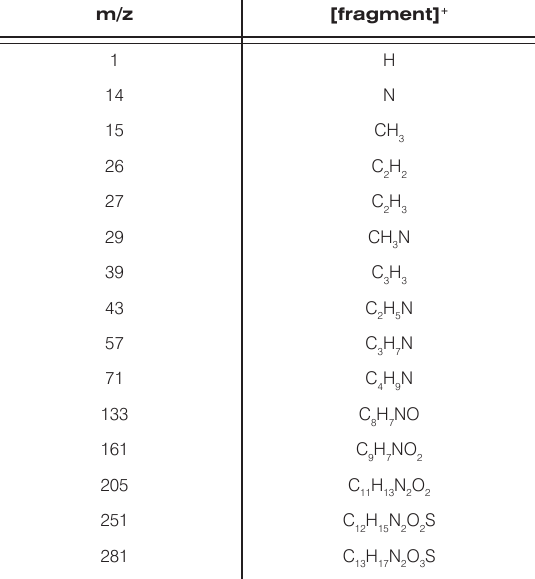
Table 2A. Table of fragments of mercaptoacetic acid SAM onto the Ag functionalisated with L-Tryptophan in positive mode.